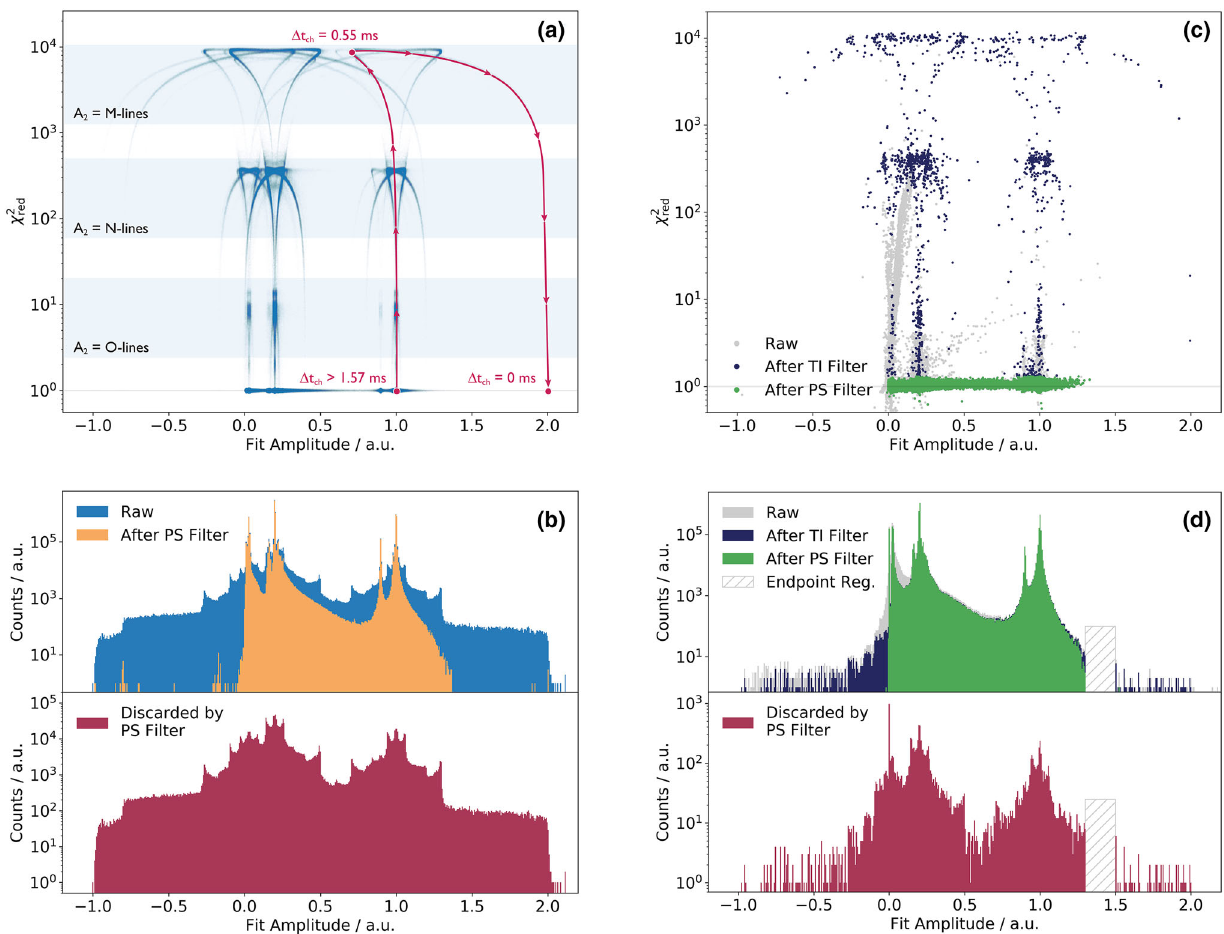
Fig. 9 Simulated ( a , b ) and ECHo-1k data ( c , d ). a Fit amplitude vs. χ 2 scatter plot of simulated events. An exemplary path of decreasing red Δ t = A = 1 and Π = + 1 is indicated in red. The loca- ch for A 1 2 tion of the maximum of the arc-shaped structures is determined by the amplitude of the pulse on the tail A 2 . b Histogram of the fit amplitude of simulated events before and after applying the pulse shape filter. The large fraction of pileup is caused by the truncated Δ t ch distribution used for the simulation. The structure in the histogram of traces dis- carded by the pulse shape filter is discussed in the text. c Fit amplitude